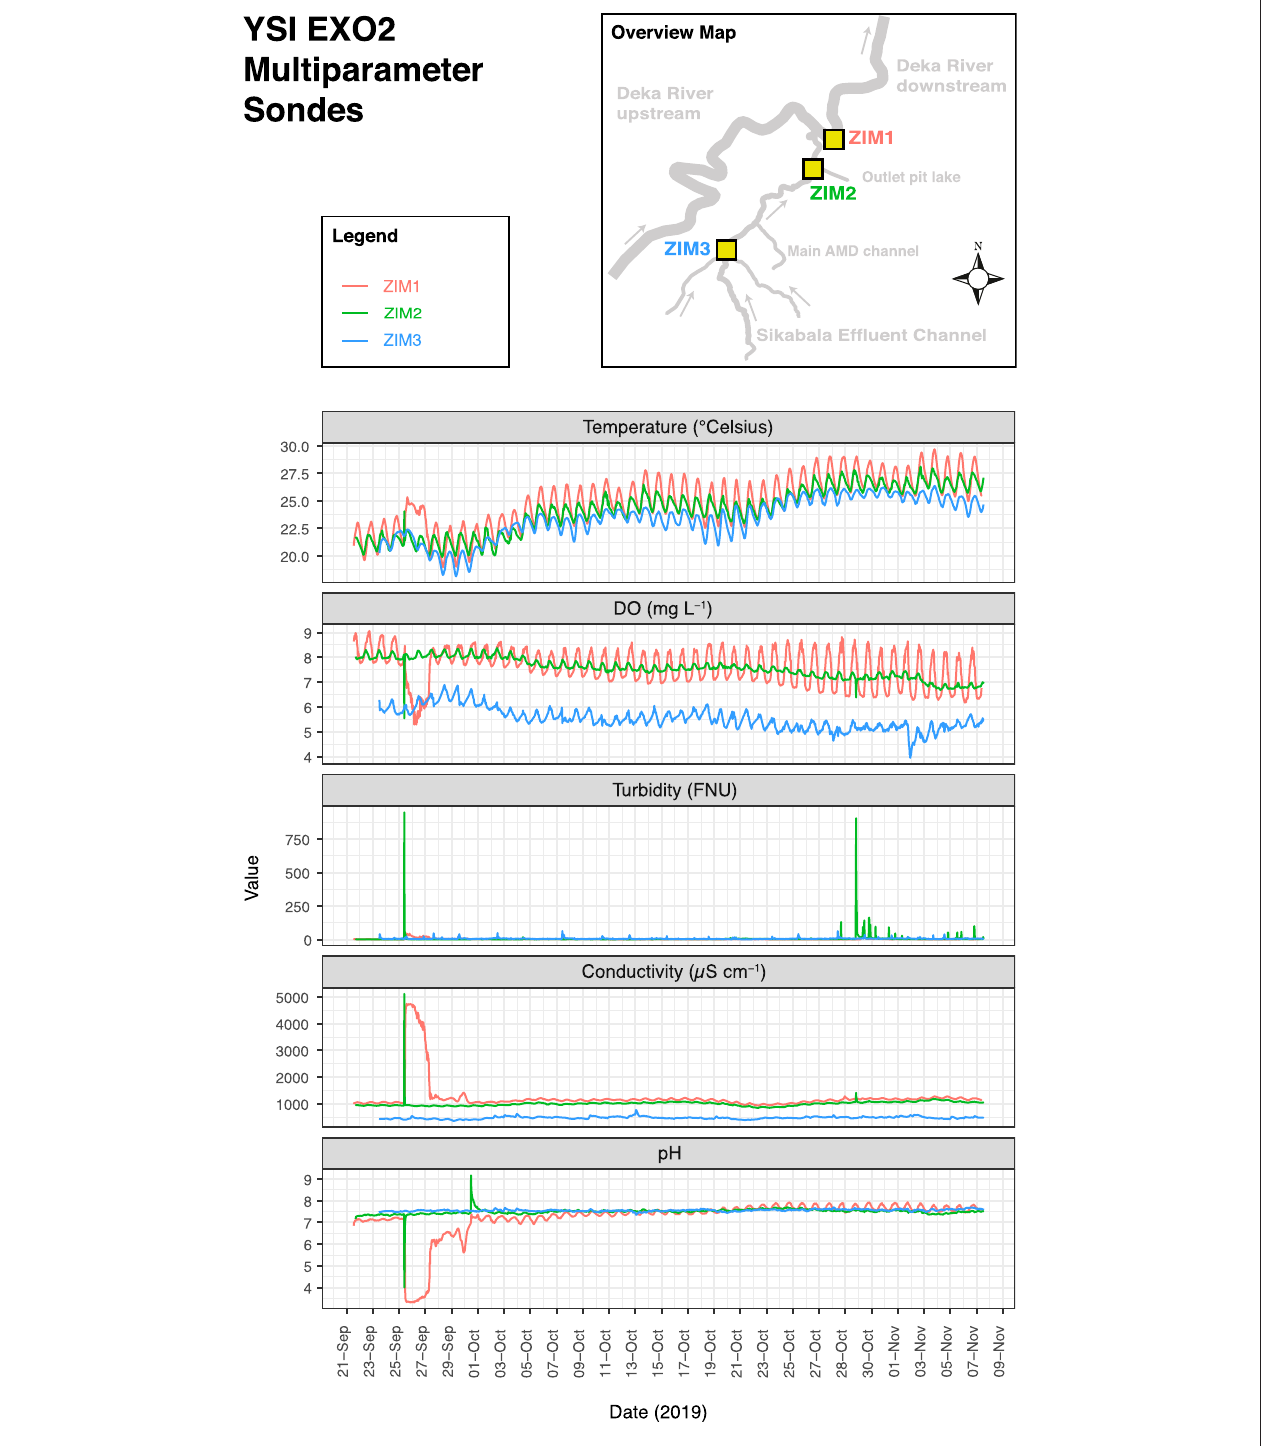
FIGURE 4 | Temperature, dissolved oxygen (DO), turbidity, conductivity and pH measured by the YSI EXO2 Multiparameter Sondes (ZIM1, ZIM2, and ZIM3) from September 23 to November 8, 2019. Overview map shows probe locations: ZIM1 monitored the Deka River downstream of the Sikabala inlet. ZIM3 was located in Sikabala upstream of the main in fl ow of mine water and ZIM2 downstream of it.